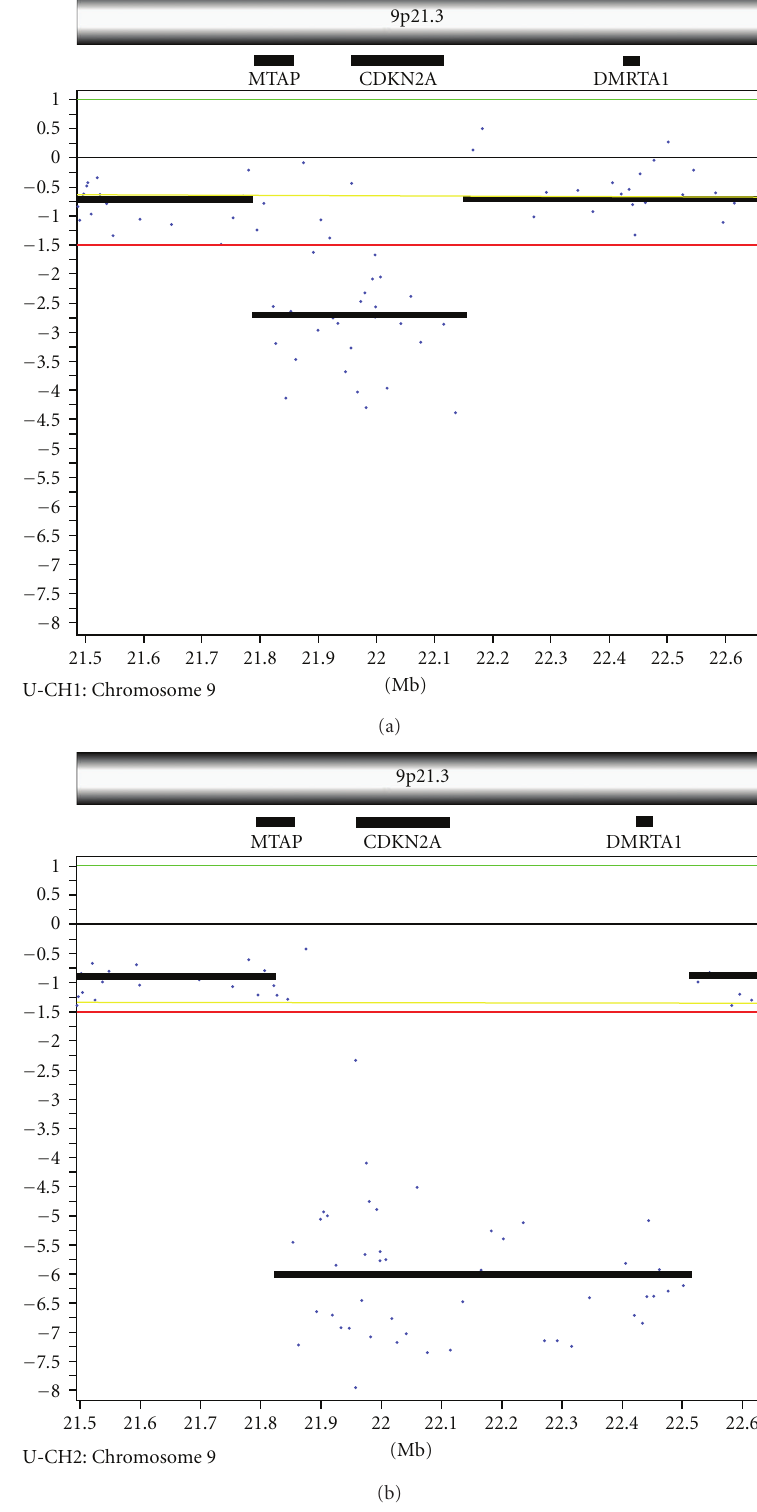
Figure 5: Chromosome9p21.3 region from array CGH analysisof U-CH1 (a)and U-CH2 (b) cell lines. Both cell lines showlossofthe 9p21.3 region encompassing CDKNA2, encoding the cyclin dependent kinase inhibitor p16, MTAP, encoding methylthioadenosine phosphatase, and for U-CH2, DMRTA1, encoding the transcription factor DMRT-family A1 protein. Each dot represents the copy number for the array probe for that region, and a line shows the copy number averaged across the region. Relative signal intensity values are shown on the y-axis; threshold log 2 ratio of .2 or .6 was used for gain or large gain, and − .2 and − 1 were used for loss and large